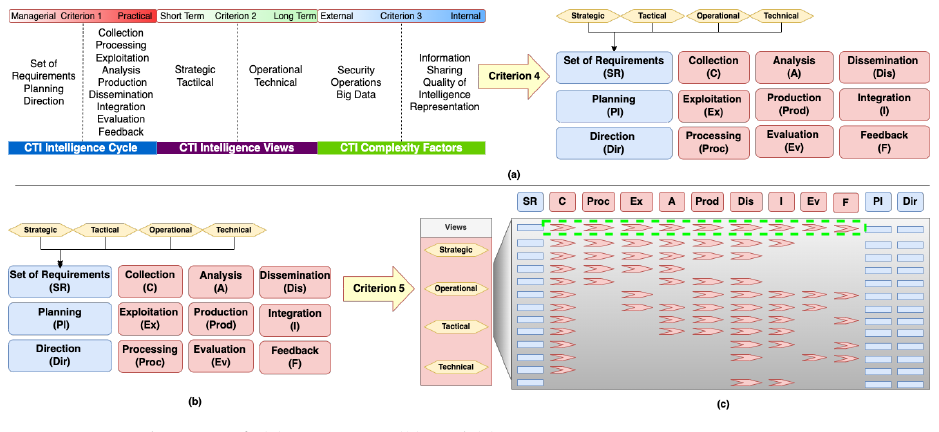
Figure 7. Application of: ( a ) Criteria 4, ( b ) and ( c ) Criteria